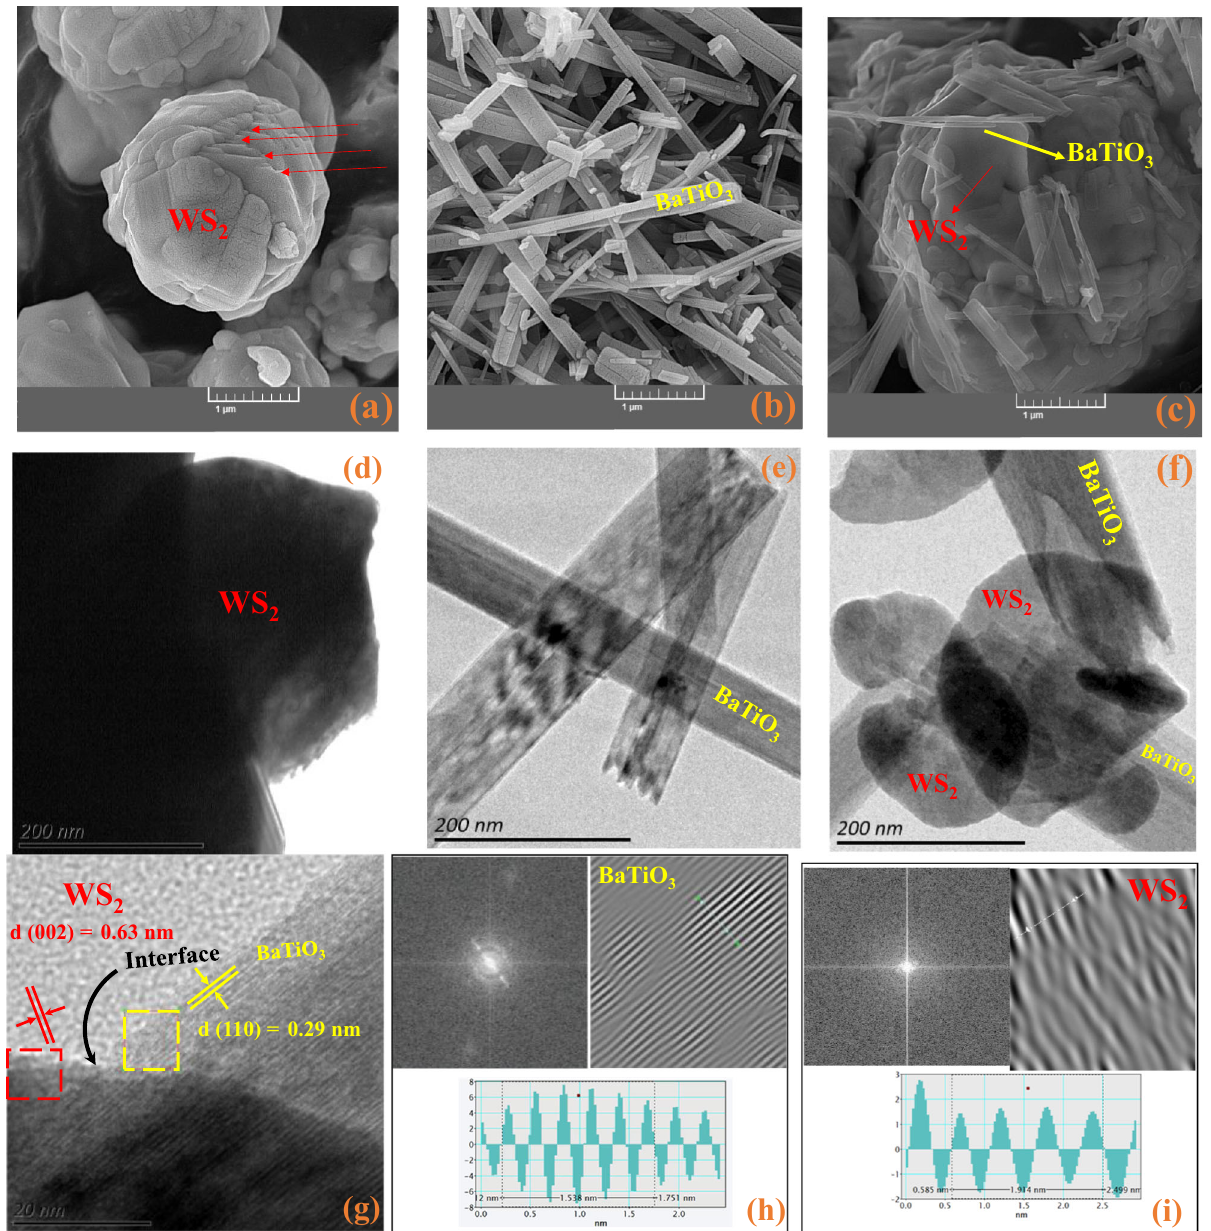
Fig. 2 Morphological analysis of the materials. a – c SEM, and d – f TEM images of WS 2 , BaTiO 3 , and the BaTiO 3 /WS 2 composite, respectively. g HR-TEM image of the BaTiO 3 /WS 2 composite and d-spacing calculated for h BaTiO 3 and i WS 2 using the selected areas on